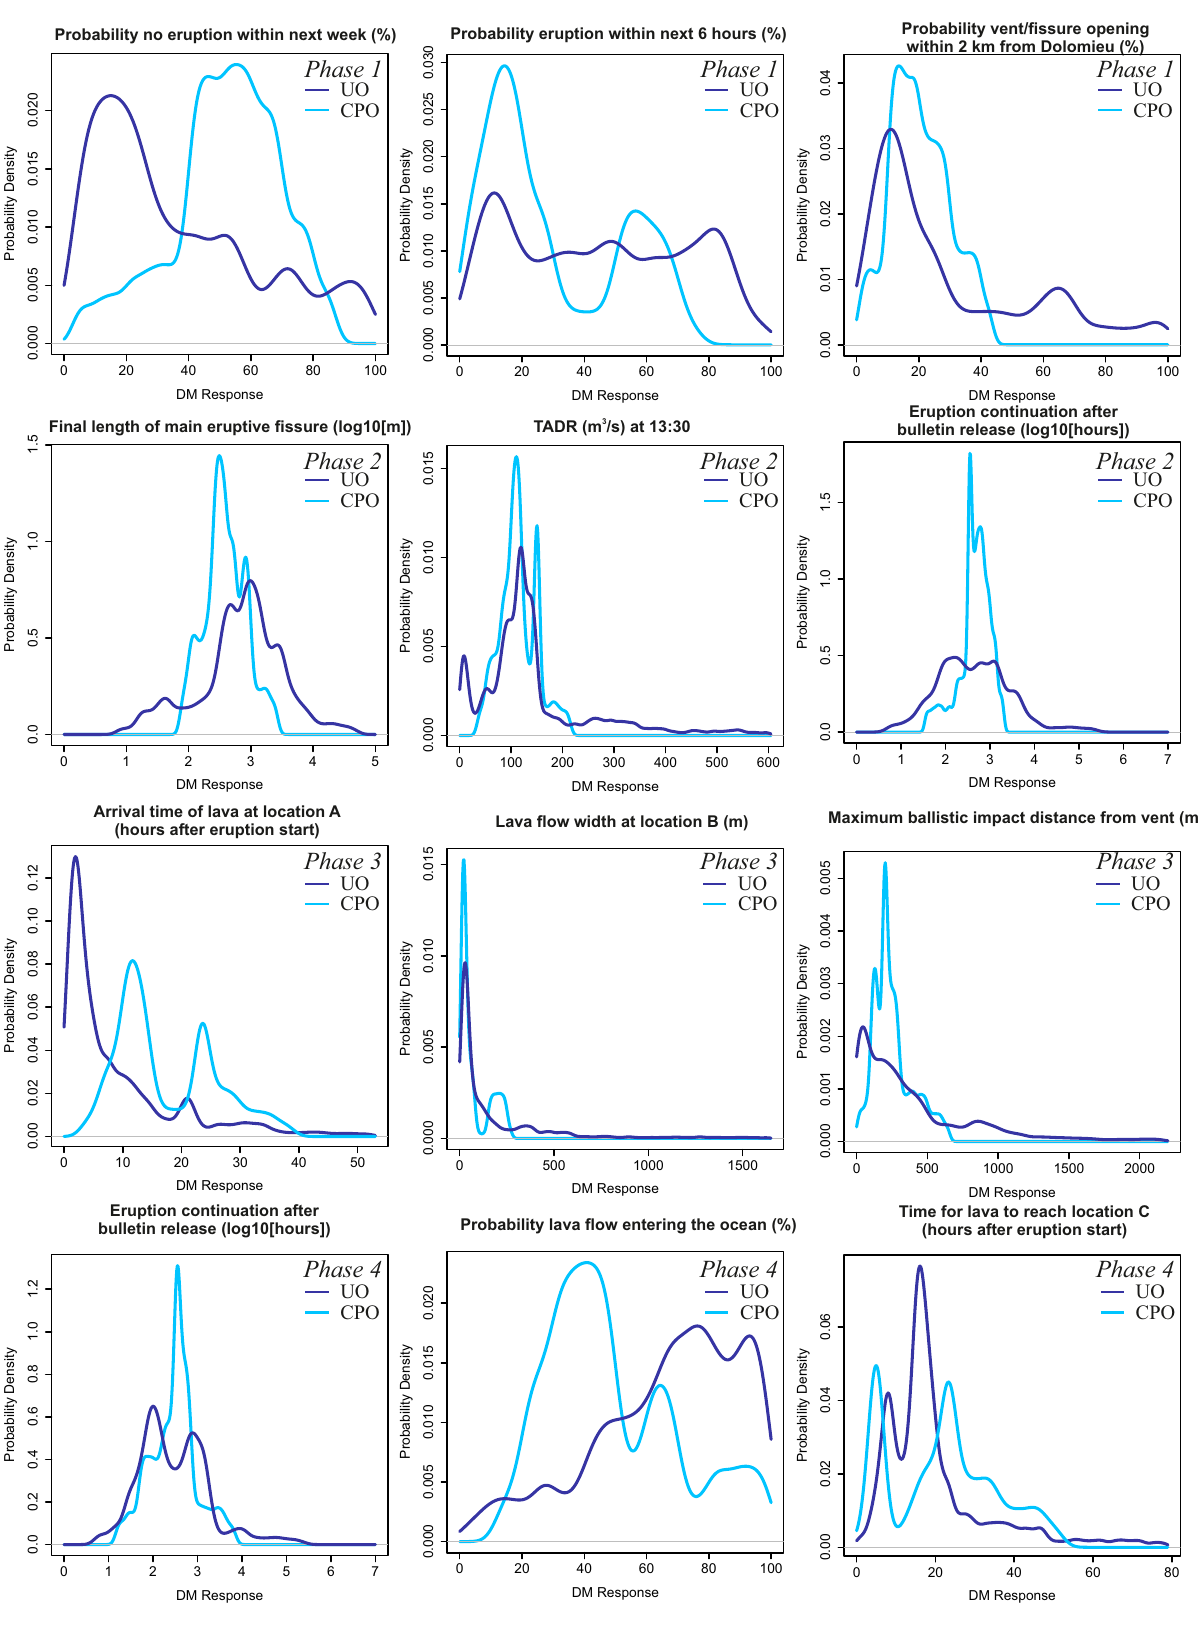
Figure 7: Probability density functions for the decision maker (DM) obtained with the Equal Weight pooling method for the “University/Observatory staff” (UO—dark blue lines) and “Civil Protection officers/Others” (CPO—light blue lines). For Q1 & Q3 in Phase 2 and Q1 in Phase 4, the x axis is a logarithmic